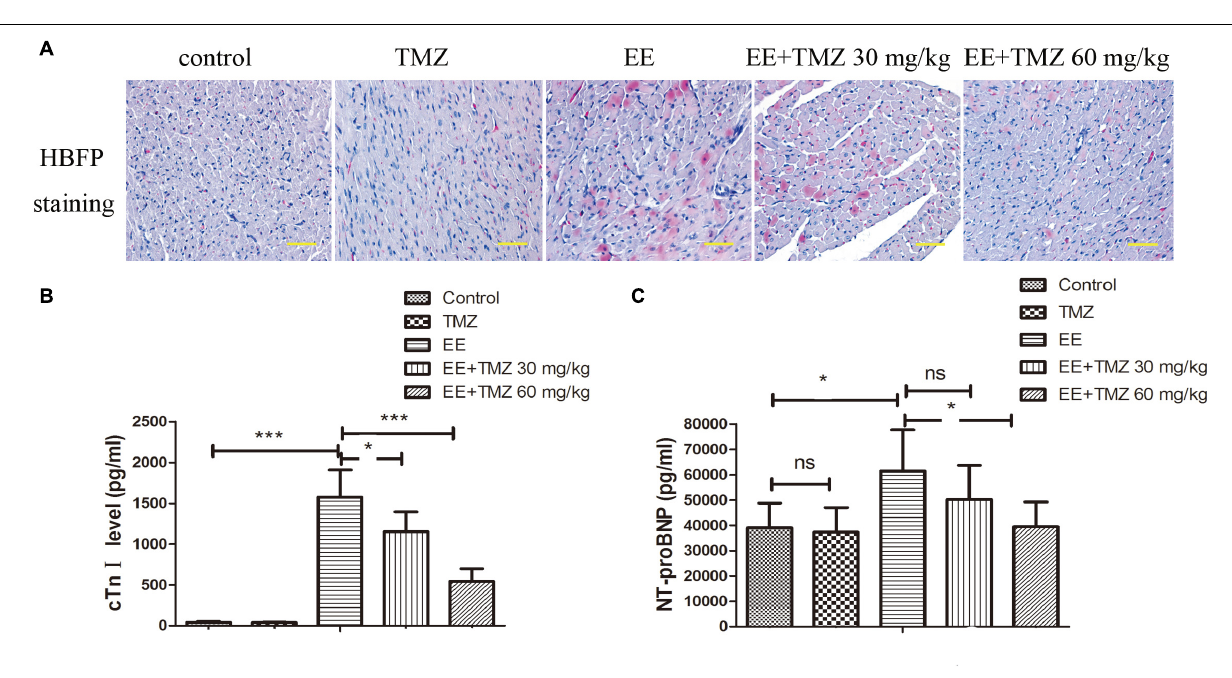
FIGURE 3 | Trimetazidine alleviated EE-induced myocardial injury. (A) Myocardial ischemia was detected by HBFP staining. Scale bar is 50 µ m. The serum cardiac troponin I (cTnI) (B) and N-terminal pro-brain natriuretic peptide (NT-proBNP) (C) levels were assessed by commercial ELISA kits. Each value is shown as mean ± SD ( n = 6). ∗ P < 0.05, ∗∗∗ P < 0.001, versus the indicated